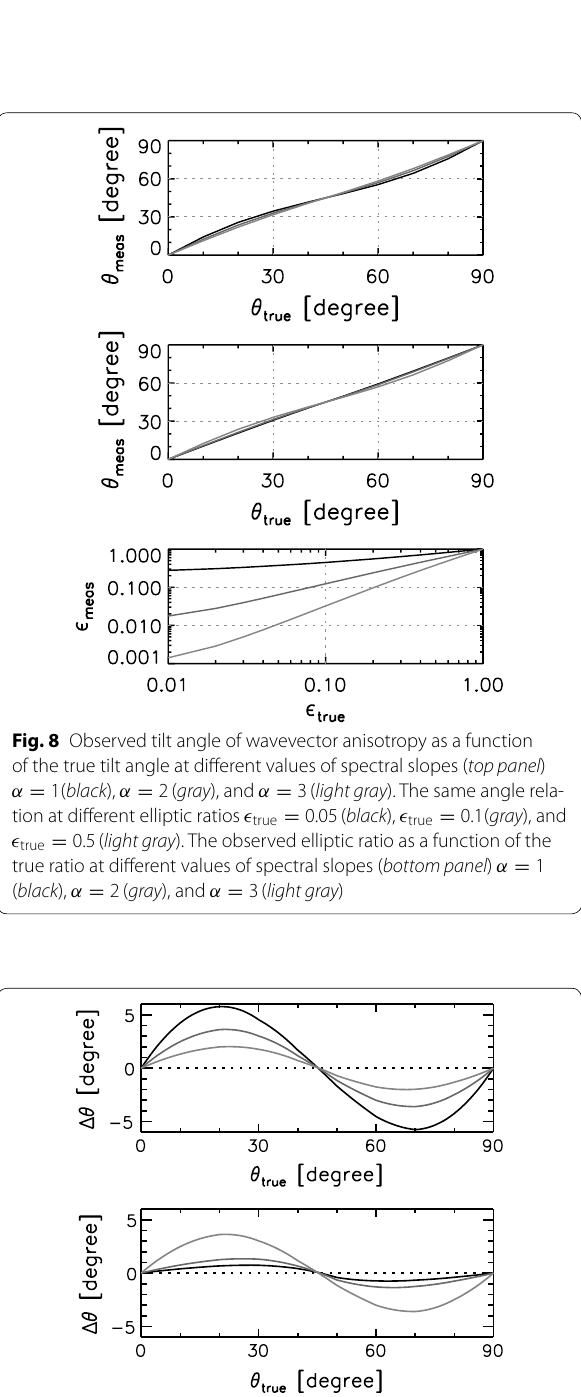
Fig. 9 Tilt angle deviations of the measured principal axis from the true anisotropy direction (spectral extension direction) for Fig. 8 top and middle panels . Top panel shows the angle mismatch for different values of spectral slopes: α = 1 ( black ), α = 2 ( gray ), and α = 3 ( light gray ). Bottom panel shows the angle mismatch for different elliptic ratios ǫ true = 0.05 ( black ), ǫ true = 0.1 ( gray ), and ǫ true = 0.5 ( light gray )